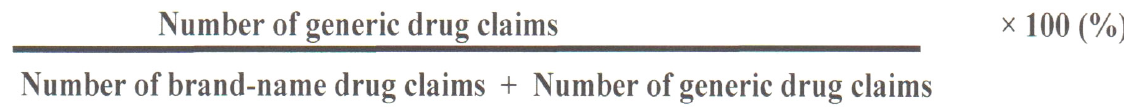
Figure 1. Formula for calculating the percentage of generic drug usage. The data used were the number of claims for the period between April 2018 and March 20219. For the correlation analysis, both of the values (upper limit 200%) were used for dental use (in-hospital).